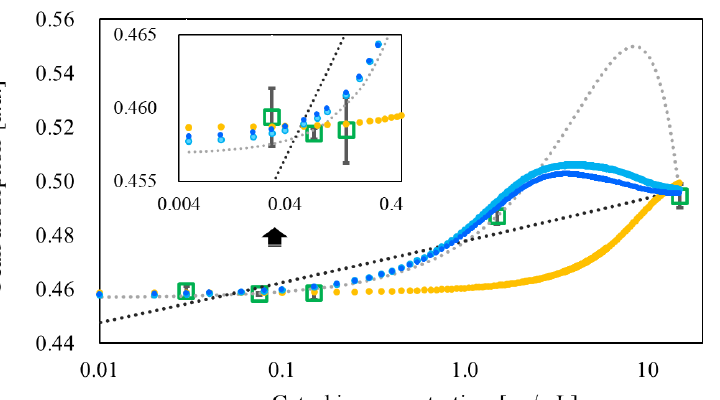
Figure 5. Prediction results of (8,4)/(9/4) absorption peaks for catechin concentration input using BRBPNN: The blue circles represent the BRBPNN model’s output from learned data. The orange circles represent the BRBPNN model’s outputs when the learned excluding the catechin 1.5 µ g/mL. The light blue circles represent the BRBPNN model’s output when learned excluded the catechin 0.075 µ g/mL. The green squares, black lines and gray dotted lines represent the validation data, the power approximation lines and the polynomial approximation lines (quadratic) for them, respec- tively.